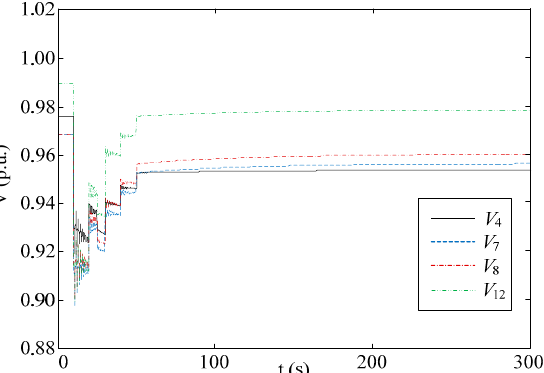
Figure 14. Voltage evolution using AH-MPC with disturbance occurred during the control process.